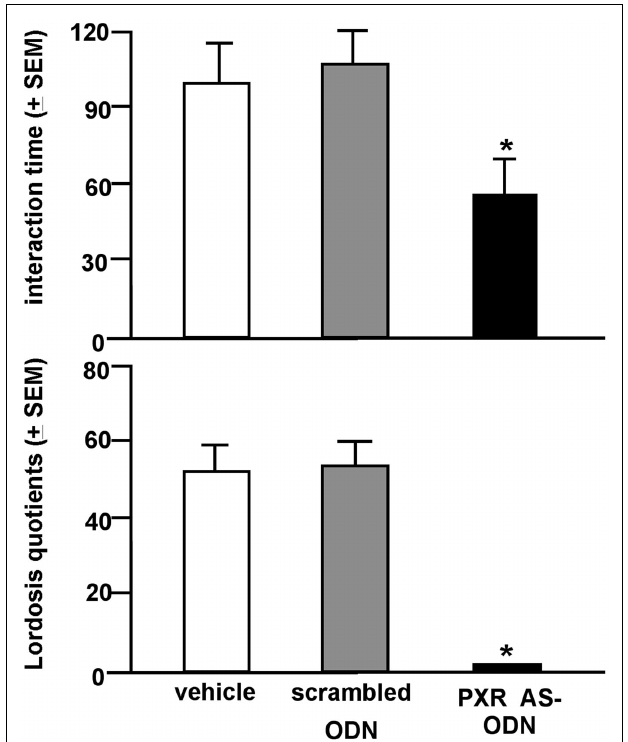
FIGURE 8 | Social behavior (top: social interaction; bottom: lordosis) of E 2 -primed rats administered scrambled control or pregnane xenobiotic receptor (PXR) antisense oligodeoxynucleotides (ODNs) to the midbrainVTA. ∗ Indicates different from all groups, p < 0.05.